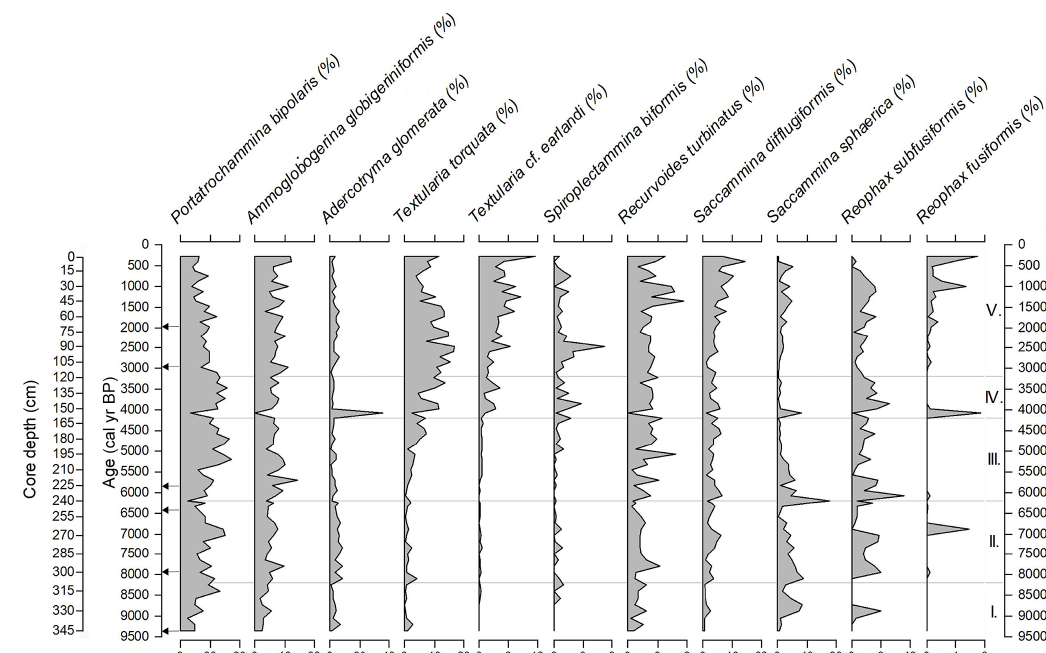
Figure 6. Relative abundances of the most abundant ( > 5% in at least one sample) agglutinated benthic foraminiferal species (expressed as a percentage of total benthic foraminiferal content) versus calibrated age along sediment core DA17-NG-ST07-73G. Ecozones (I–V) are shown on the right side of the figure. Black arrows next to the left primary y axis (age) mark radiocarbon dates. Note that the x axes have different